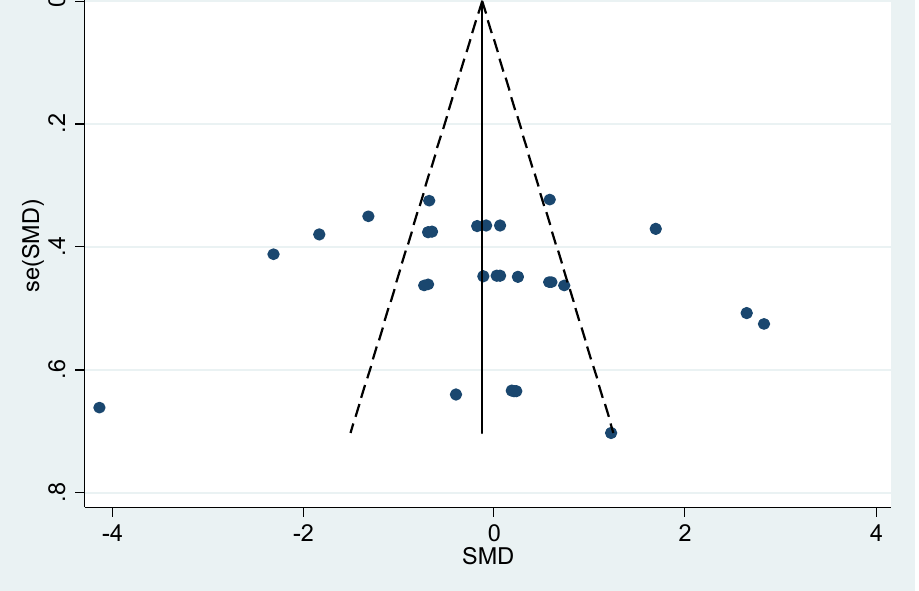
Figure 3. Funnel Plot of Overall Marginal Fit.